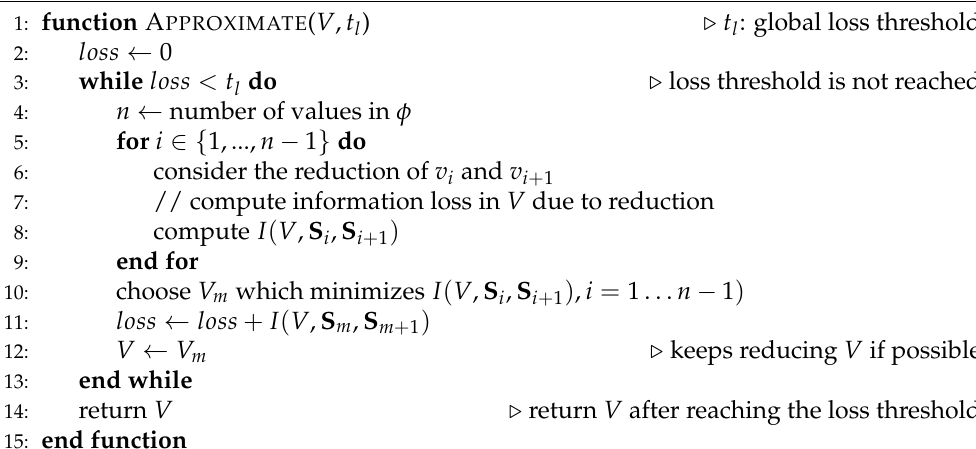
Algorithm 1 Approximation of a potential φ represented as V ( VBP